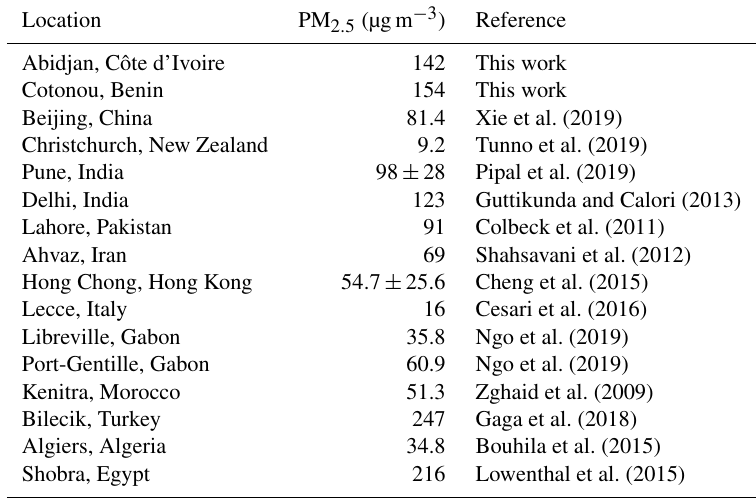
Table 4. Comparison of PM 2 . 5 concentrations with literature data. Only literature data given at a daily scale have been selected.